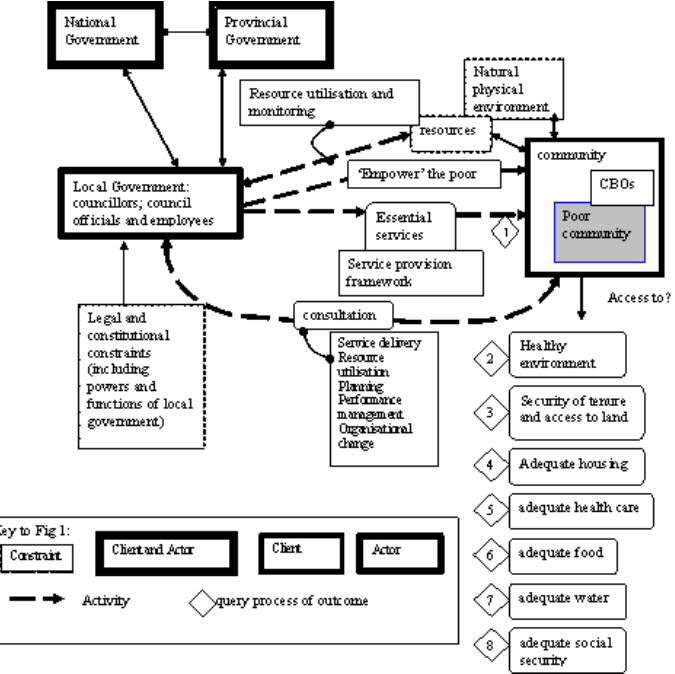
Figure 1: A rich picture of developmental local